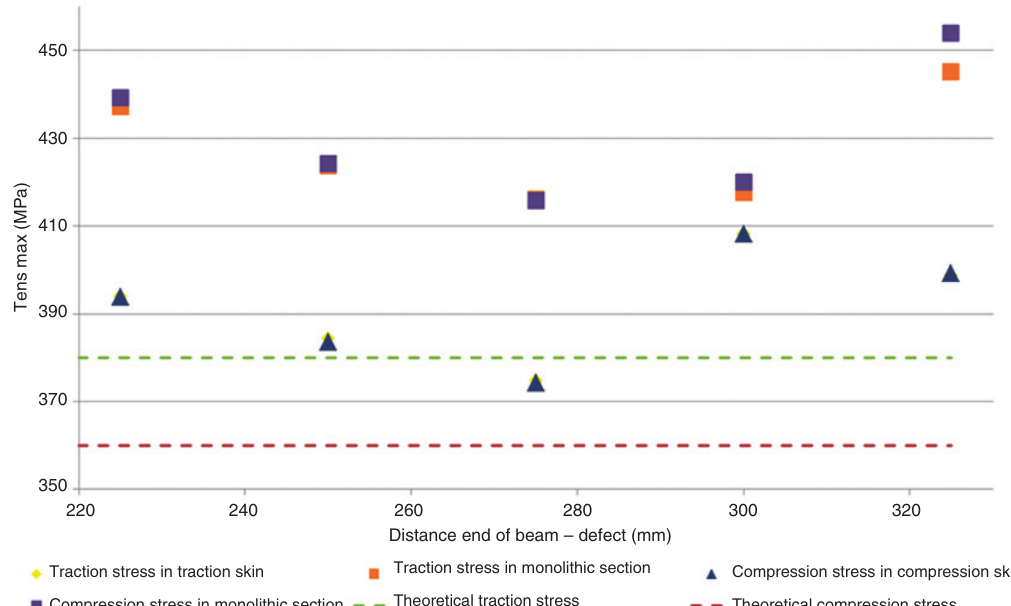
Figure 10 Influence of distance defect – end beam in maximum